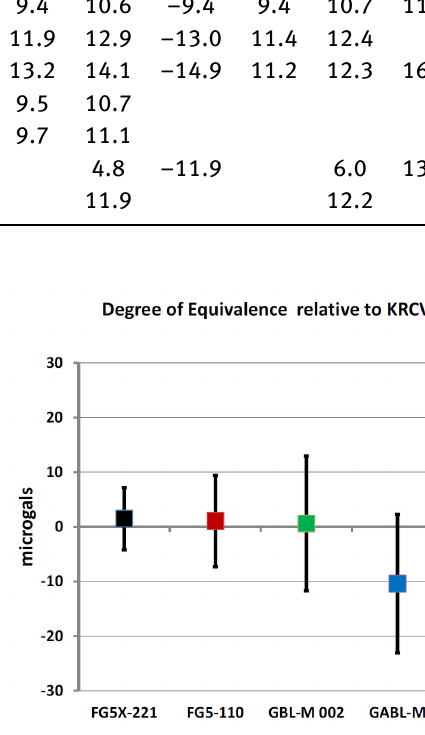
Figure 4: Final RFCAG2013 results: the offsets of the 5 AGs relative to the KCRV of CCM.G-K2, with expanded uncertainties (95% con- fidence). The offsets for the FG5-110, the GBL-M 002, the GABL-M, and GABL-PM come from the column “g” of the last row of Table 7, and their uncertainties from column “U ” of the same row. The val- 2 ues for the FG5X-221 are from the CCM.G-K2. For all AGs except the GABL-M the offset is less than the expanded uncertainty, i.e. they are in equivalence with the KRCV of the